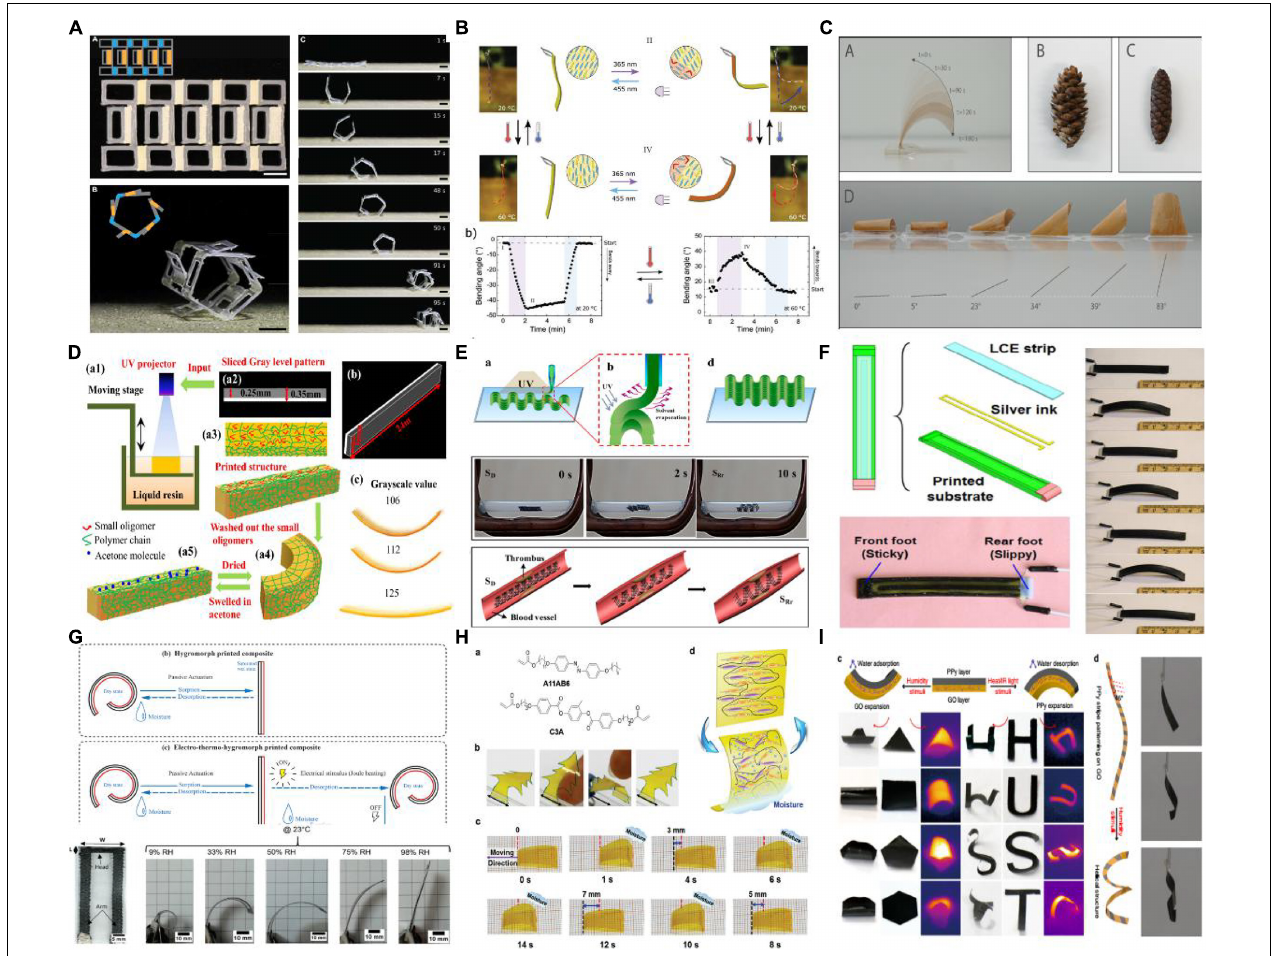
FIGURE 7 | The soft actuators mimicking the designs of plants by manipulating the stimulus in 4D printing process. (A) Shape-morphing and self-propelling of liquid crystal elastomer bilayers in programmed responses to thermal stimuli. (B) Amphibious light-fueled actuators generating motion toward/away from the light source regulated by temperature. (C) The curling and self-folding behaviors of wood in preprogrammed response to moisture. (D) Grayscale 4D-printed reversible self-folding structures by immersing in acetone and dried in air. (E) Active shape-changing architectures exhibiting magnetically guidable properties by the addition of iron oxide. (F) Joule heating stimulated active composites by printing conductive wires into LCE strips. (G) Multistimuli-responsive material by the addition of conductive carbon reinforcements into a moisture-sensitive polymer. (H) Hydrophobic cross-linked liquid crystal polymer film featuring both activation using moisture gradient and UV light. (I) Multiresponsive patternable actuator responding to humidity, temperature, and light via accurate structuring on graphene oxide films by the microstamping of